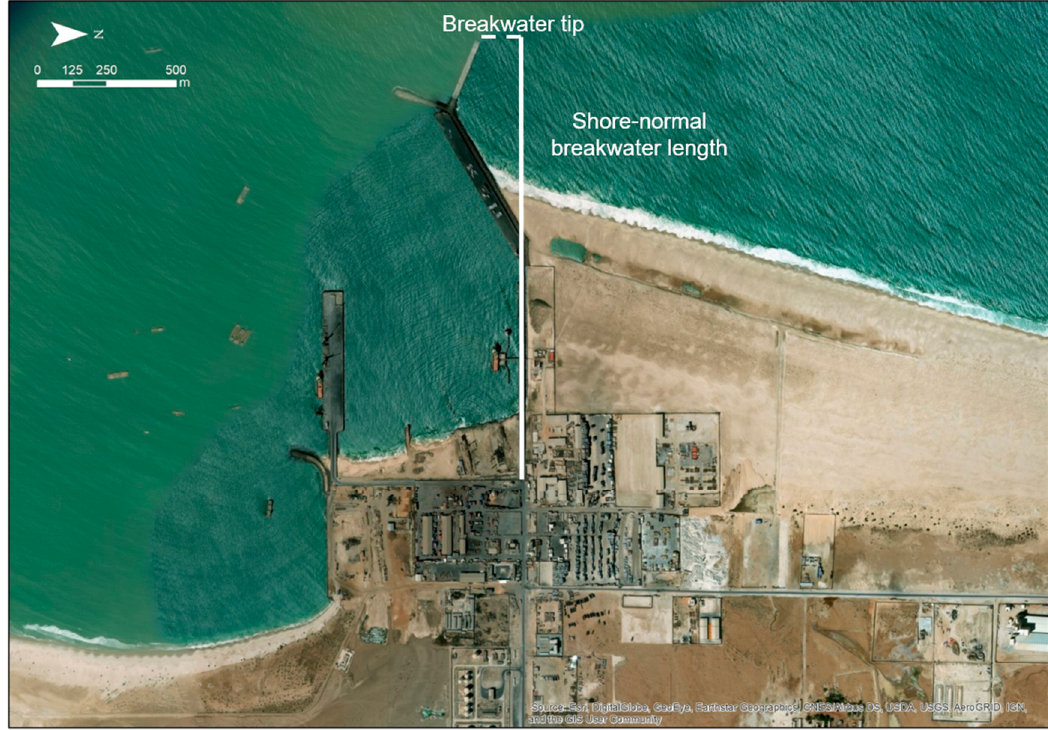
Figure 8. Illustration of the method used to determine the shore-normal breakwater length for the Port of Nouakchott (Mauritania).